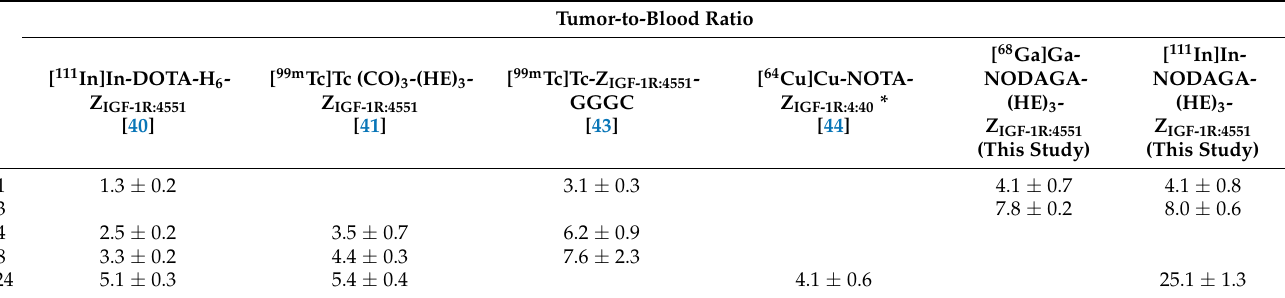
Table 4. Tumor-to-blood ratios provided by different radiolabeled variants of Z IGF-1R:4551 in DU145 prostate cancer xenografts in